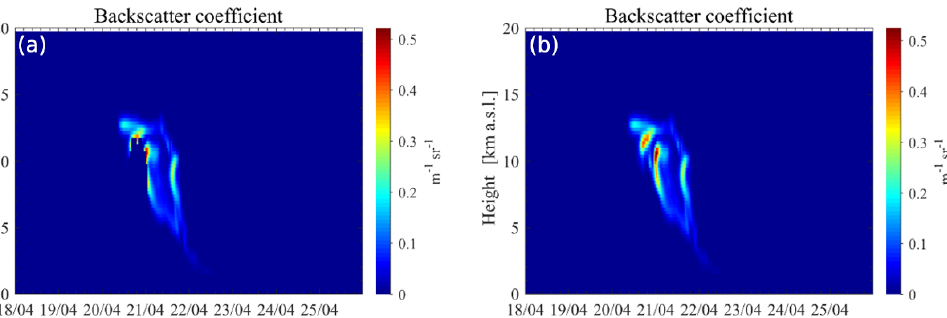
Figure 7. Particle backscatter coefficient time–height evolution when the cloud fraction is removed (a) and not removed (b) for the Barcelona EARLINET station and for the whole exercise period.